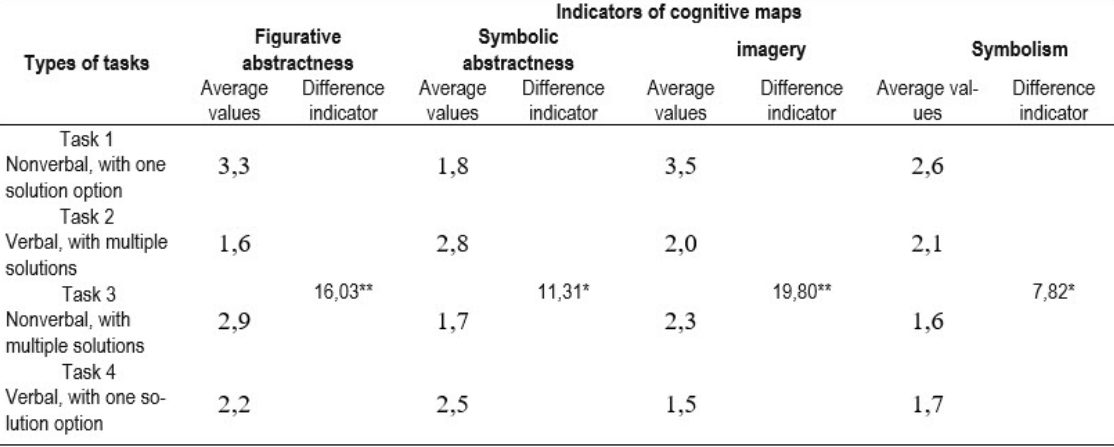
Differences in each individual indicator of cognitive maps performed under time constraints, based on the results of solving all types of